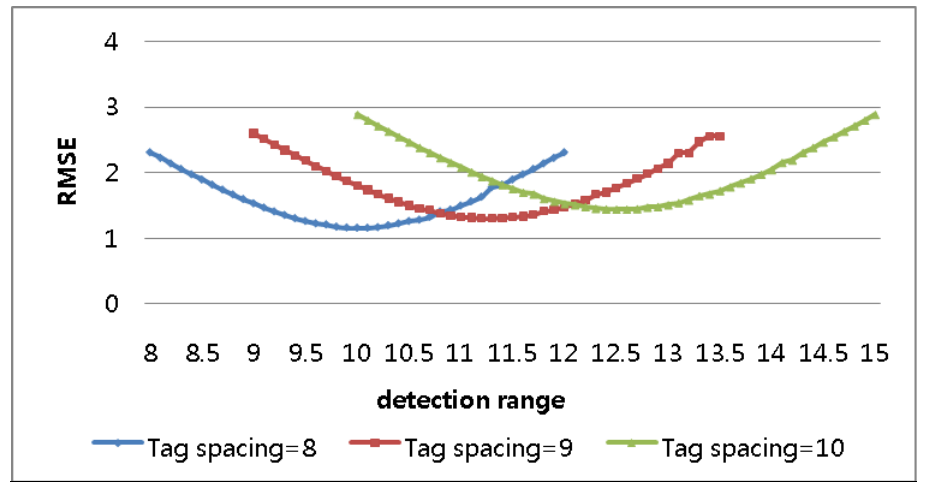
Figure 5. RMSE for detection ranges varying to 150% in 1-dimensional-space numerical approach.